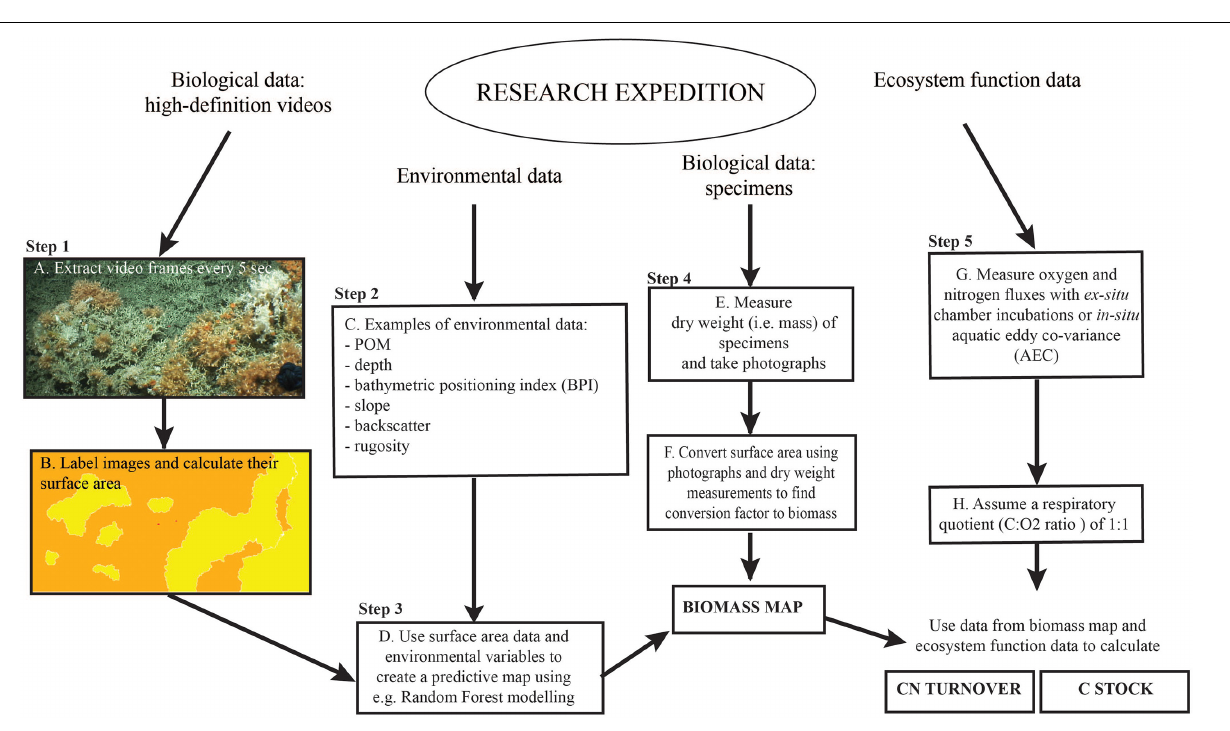
FIGURE 3 | Graphic overview of the approach used in this study. Adapted from Figure 2 in De Clippele et al.